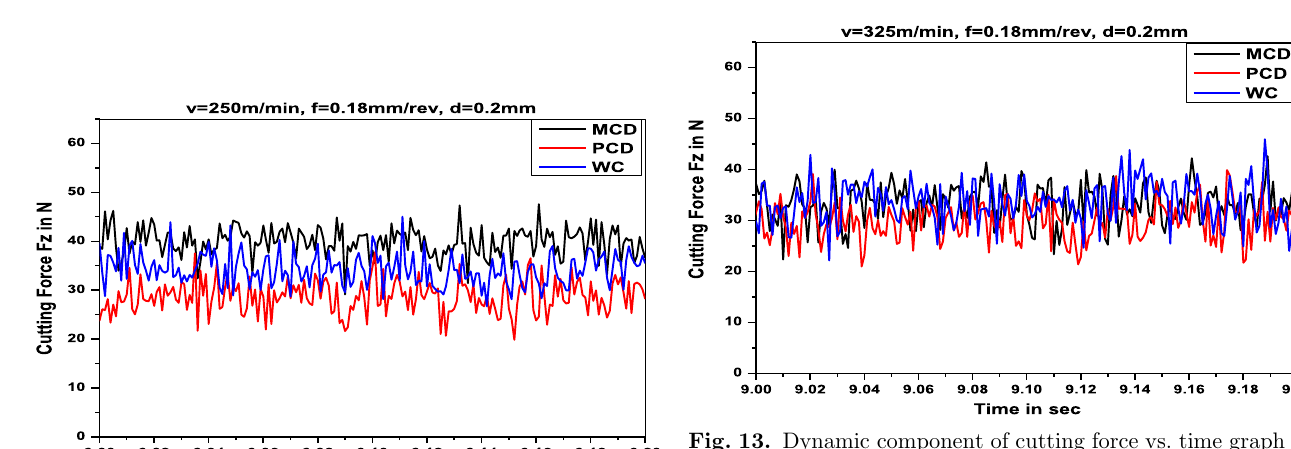
Fig. 13. Dynamic component of cutting force vs. time graph at v = 325m/min, f =0.18 mm/rev, d =